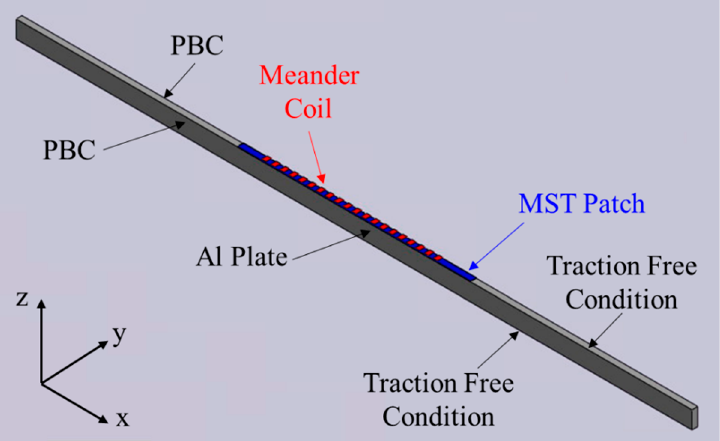
Figure 5. Transducer model schema for both SH waves and Lamb waves. The MST and the plate are surrounded by air. Periodic boundary conditions ensure planar wave propagation.